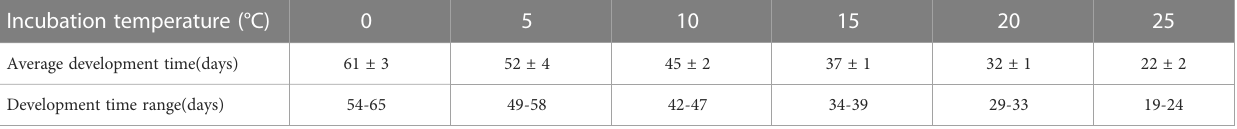
TABLE 4 The development time of O. similis at different temperature in laboratory culture experiment. Incubation temperature (°C)